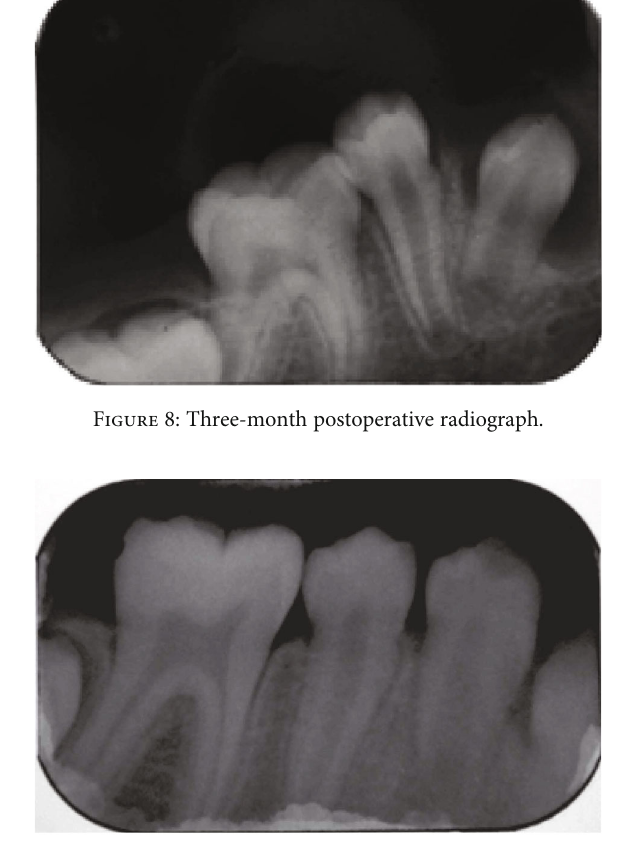
Figure 9: Twelve-month postoperative radiograph showing spontaneous eruption of the tooth 44.